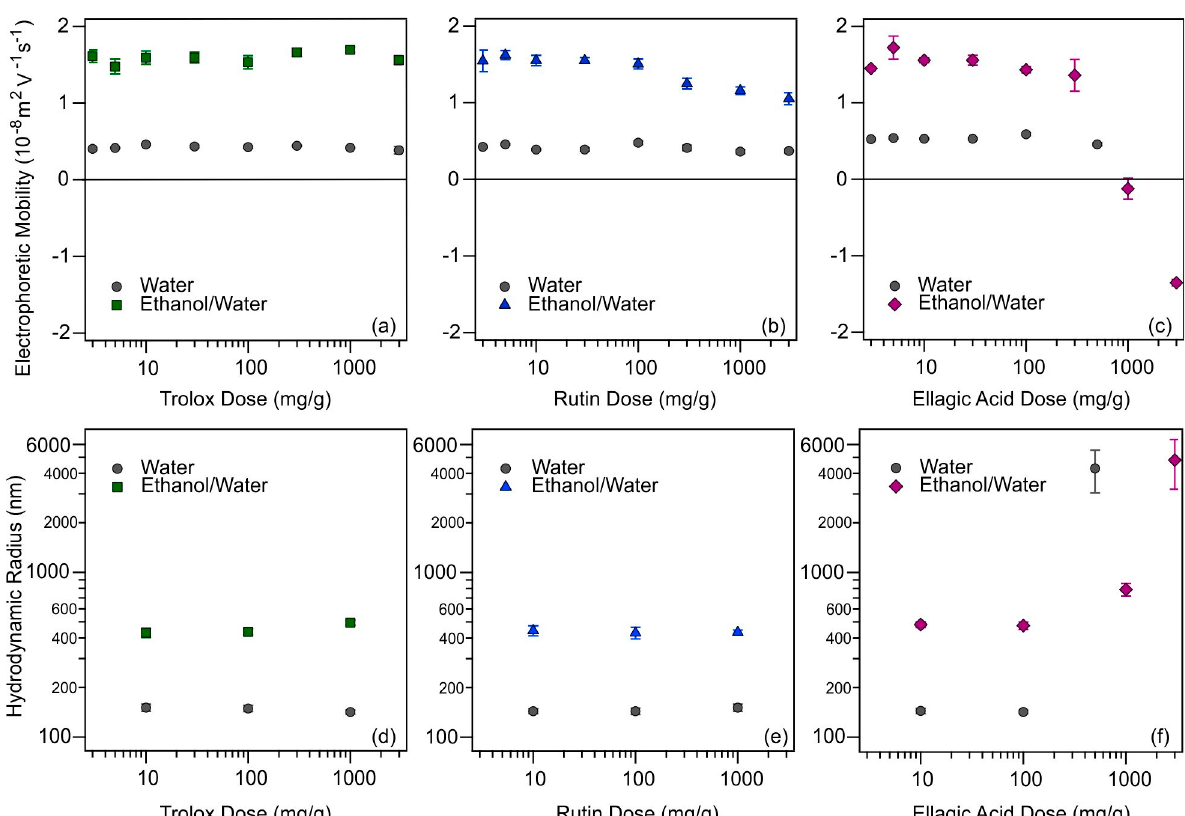
Figure 3. Electrophoretic mobilities of SL ‐ IP ‐ 2 particles as a function of the dose of trolox ( a ); rutin ( b ); and ellagic acid ( c ). The R h of SL ‐ IP ‐ 2 versus trolox ( d ); rutin ( e ); and ellagic acid ( f ) concentrations. Data determined in different solvents, water (gray circles) and ethanol/water (green squares, blue triangles, and purple diamonds, respectively) are presented. The concentration of the SL ‐ IP ‐ 2 particles was kept at 10 mg/L.